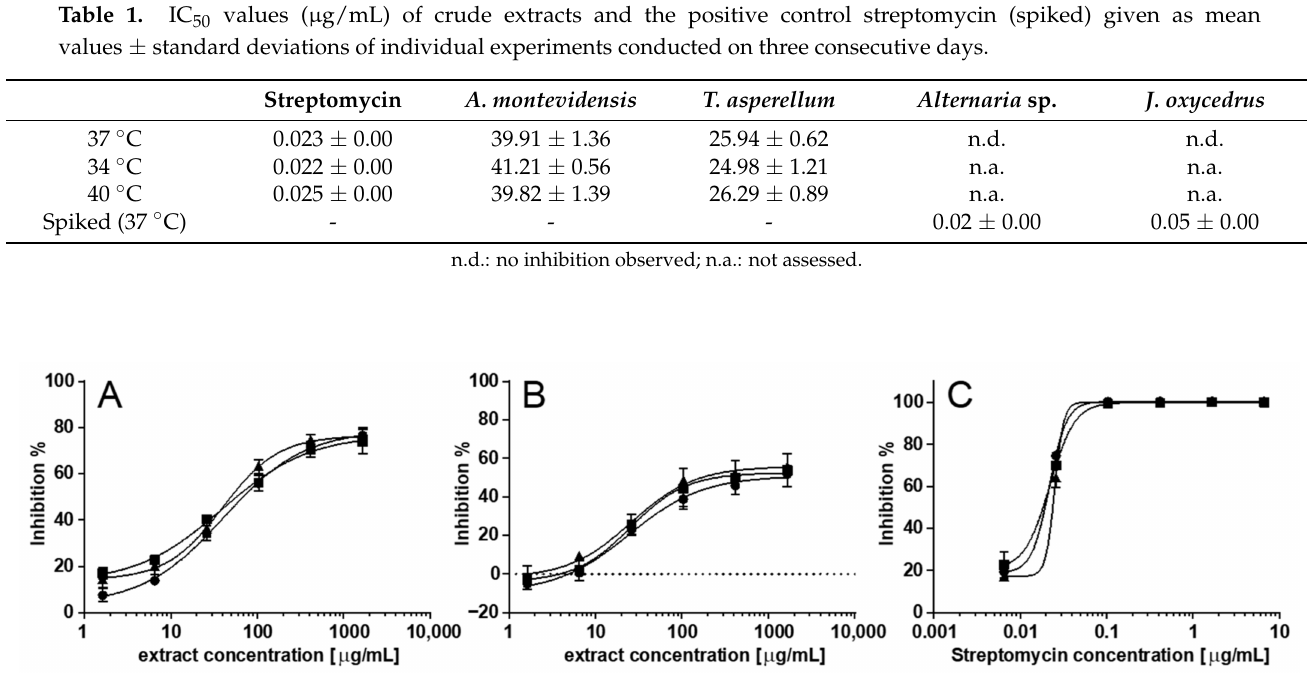
Figure 1. IC 50 curves of crude extracts of the endophytic fungi A. montevidensis ( A ) and T. asperellum ( B ), and the reference compound, streptomycin ( C ), at 34 ◦ C (circle, • ), 37 ◦ C (square, (cid:4) ) and 40 ◦ C (triangle, (cid:78) ). Measurements were performed in triplicates, representing inter-day reproducibility, and plotted as mean inhibition (%) ± standard deviations against extract concentration ( µ